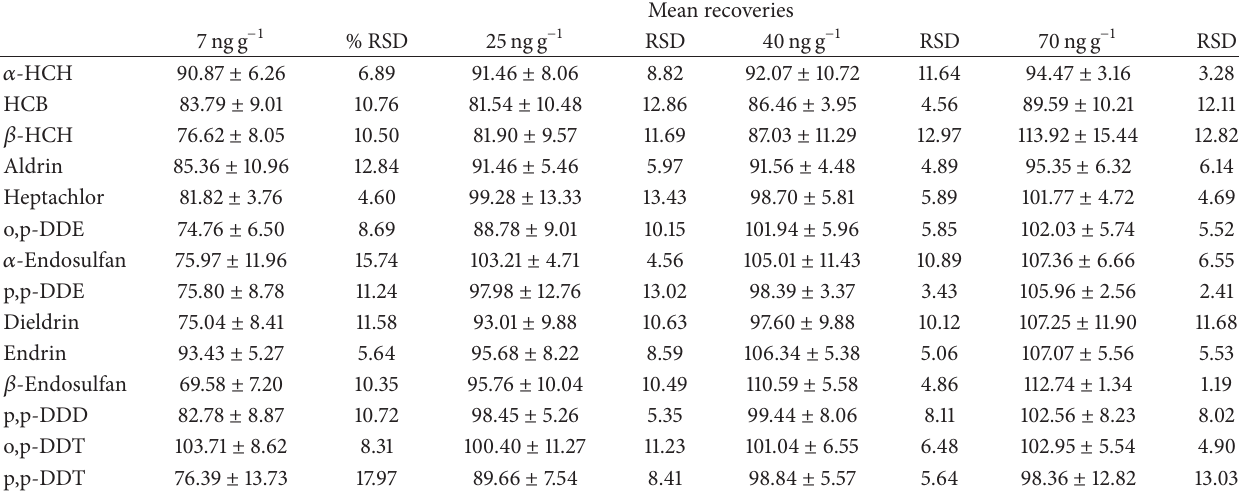
Table1:%recoveriesandtheirstandarddeviations(mean ± SD)afteranalysisofspikedblanksamples. Theprecisionofthemethodcalculated as % RSD for four measurements of each sample.